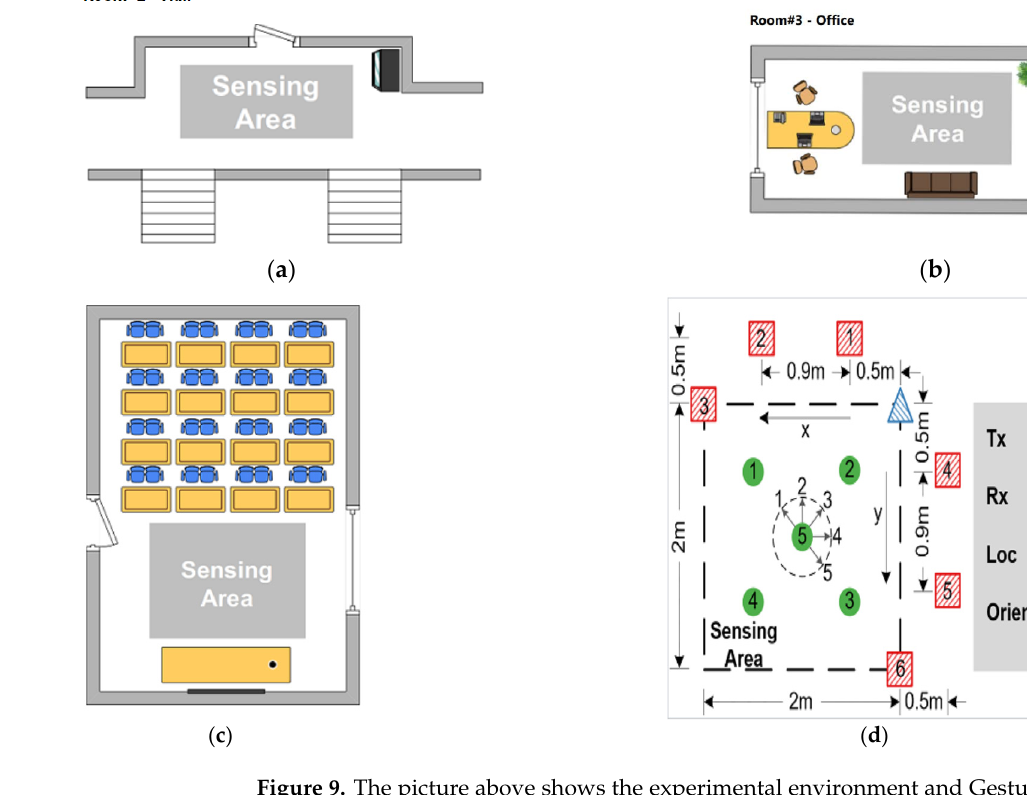
Figure 9. The picture above shows the experimental environment and Gesture drawing direction: ( a ) Hall; ( b ) Office; ( c ) Classroom; ( d ) Gesture drawing direction.